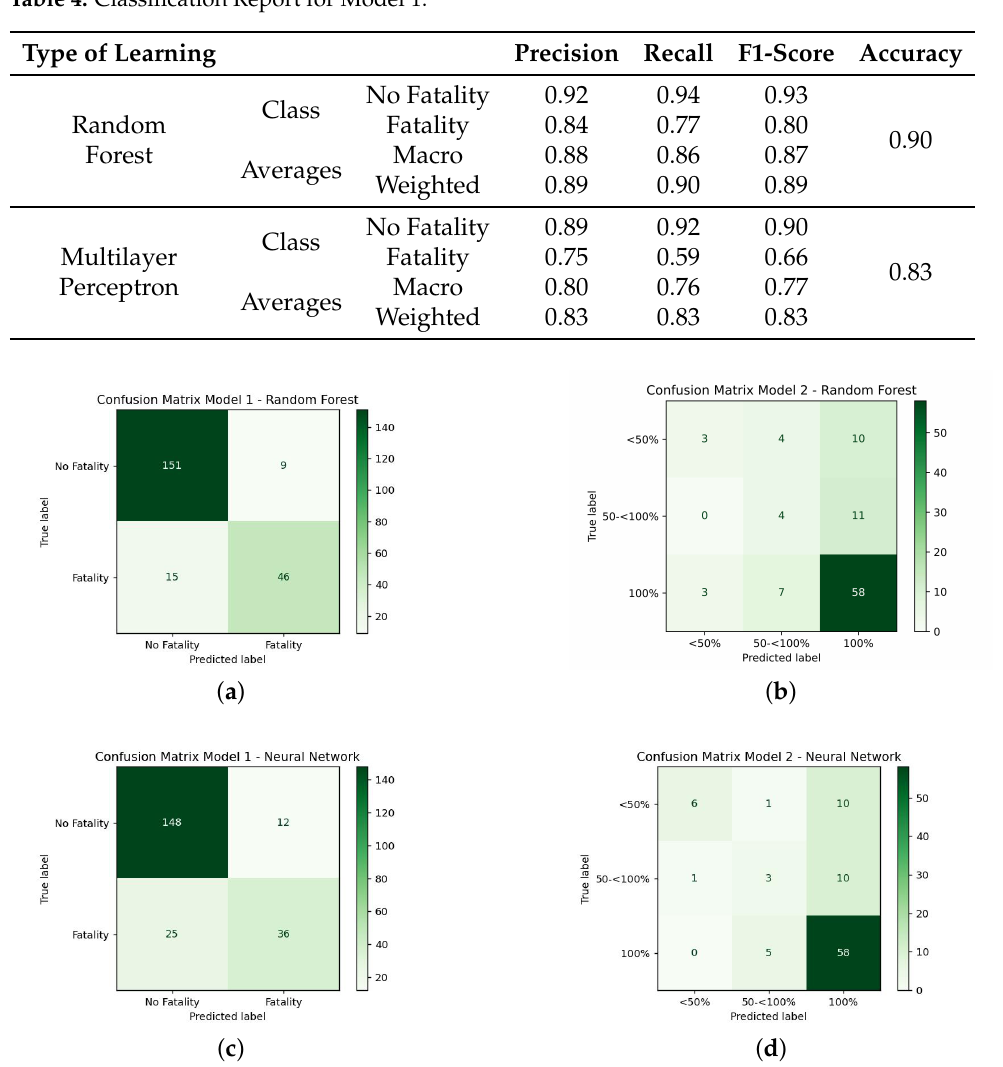
Table 4. Classification Report for Model 1.